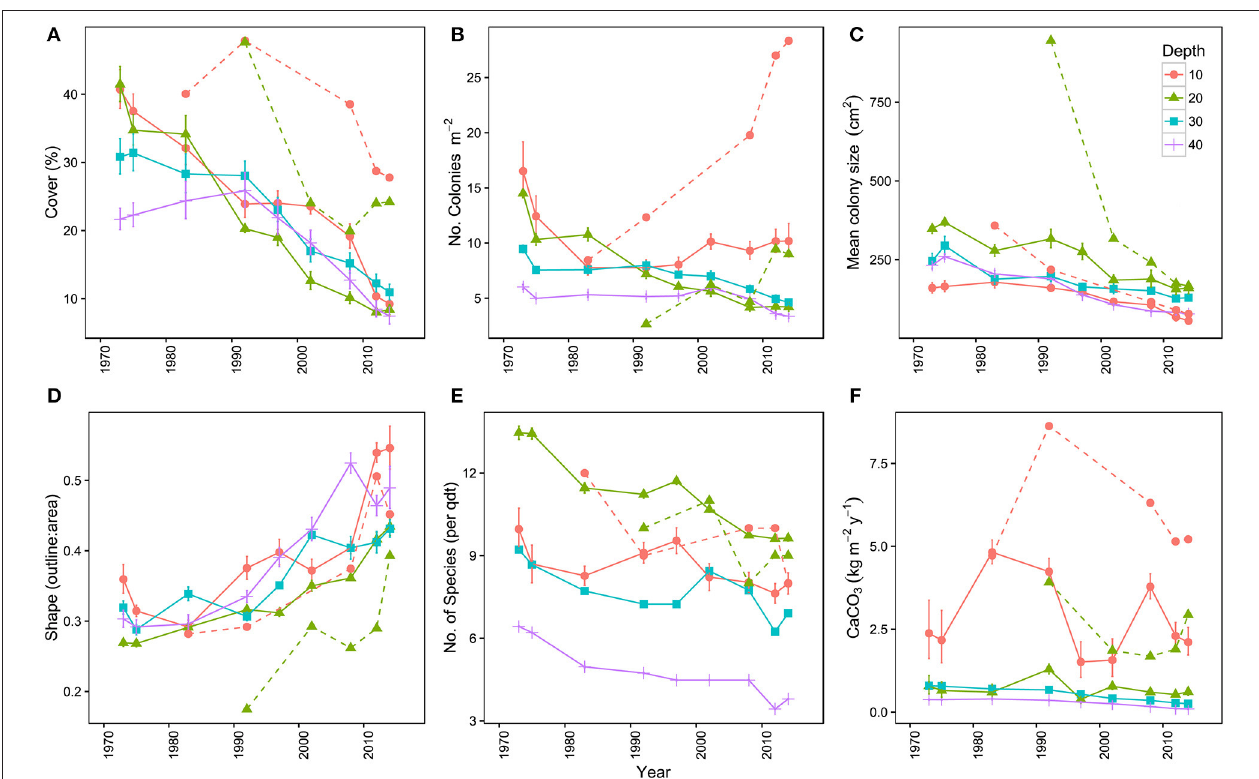
FIGURE 3 | Temporal trends in the coral communities on Curaçao and Bonaire. (A) mean percentage of the 9 m 2 quadrat covered by hard coral, (B) mean number of coral colonies per m 2 , (C) mean colony size (cm 2 ), (D) mean colony shape index represented by the outline:area ratio of corals, (E) mean number of hard coral species in the quadrats and (F) mean carbonate production (kg m − 2 y − 1 ) of the coral community. Points represent the mean of the four main locations (I–IV) at a surveyed point in time. Each color represents a specific depth. Dashed lines represent the reference site Awa Blancu (AB) at 10 and 20m depth. All means are provided with their respective 95% confidence